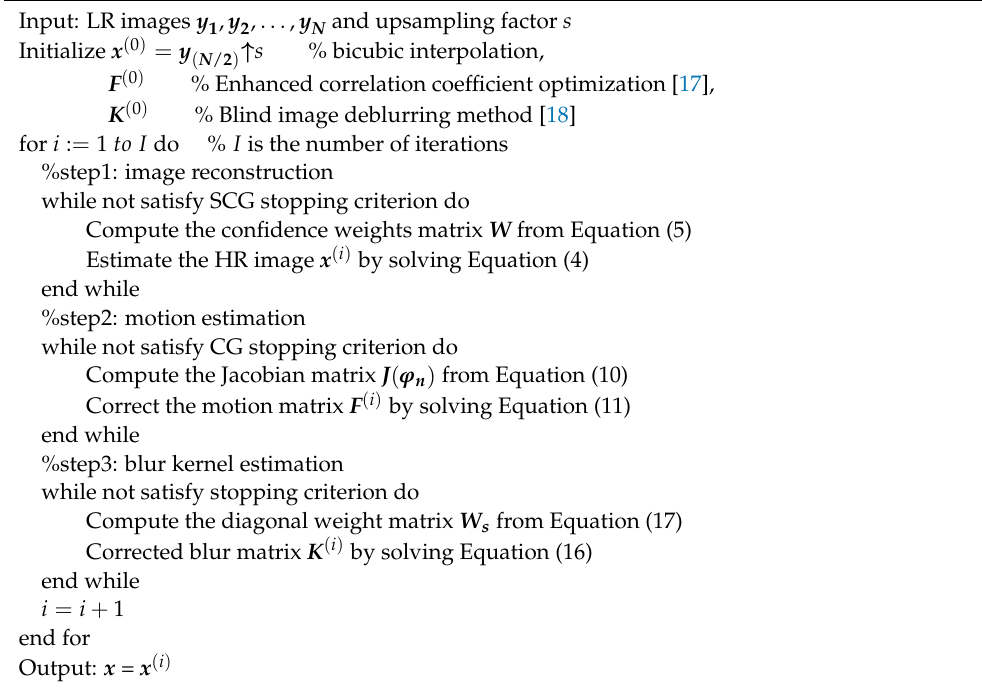
Algorithm 1. The final algorithm of multi-frame blind